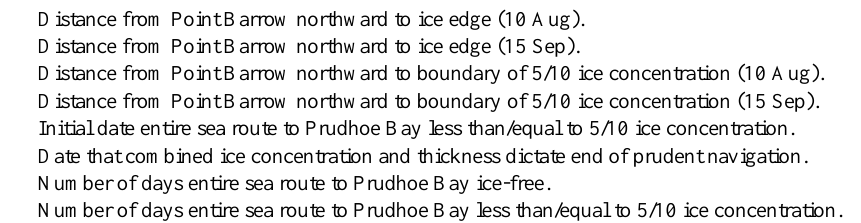
Table 2. Aspects entering the definition of the Barnett ice severity index. Distance from Point Barrow northward to ice edge (10 Aug).